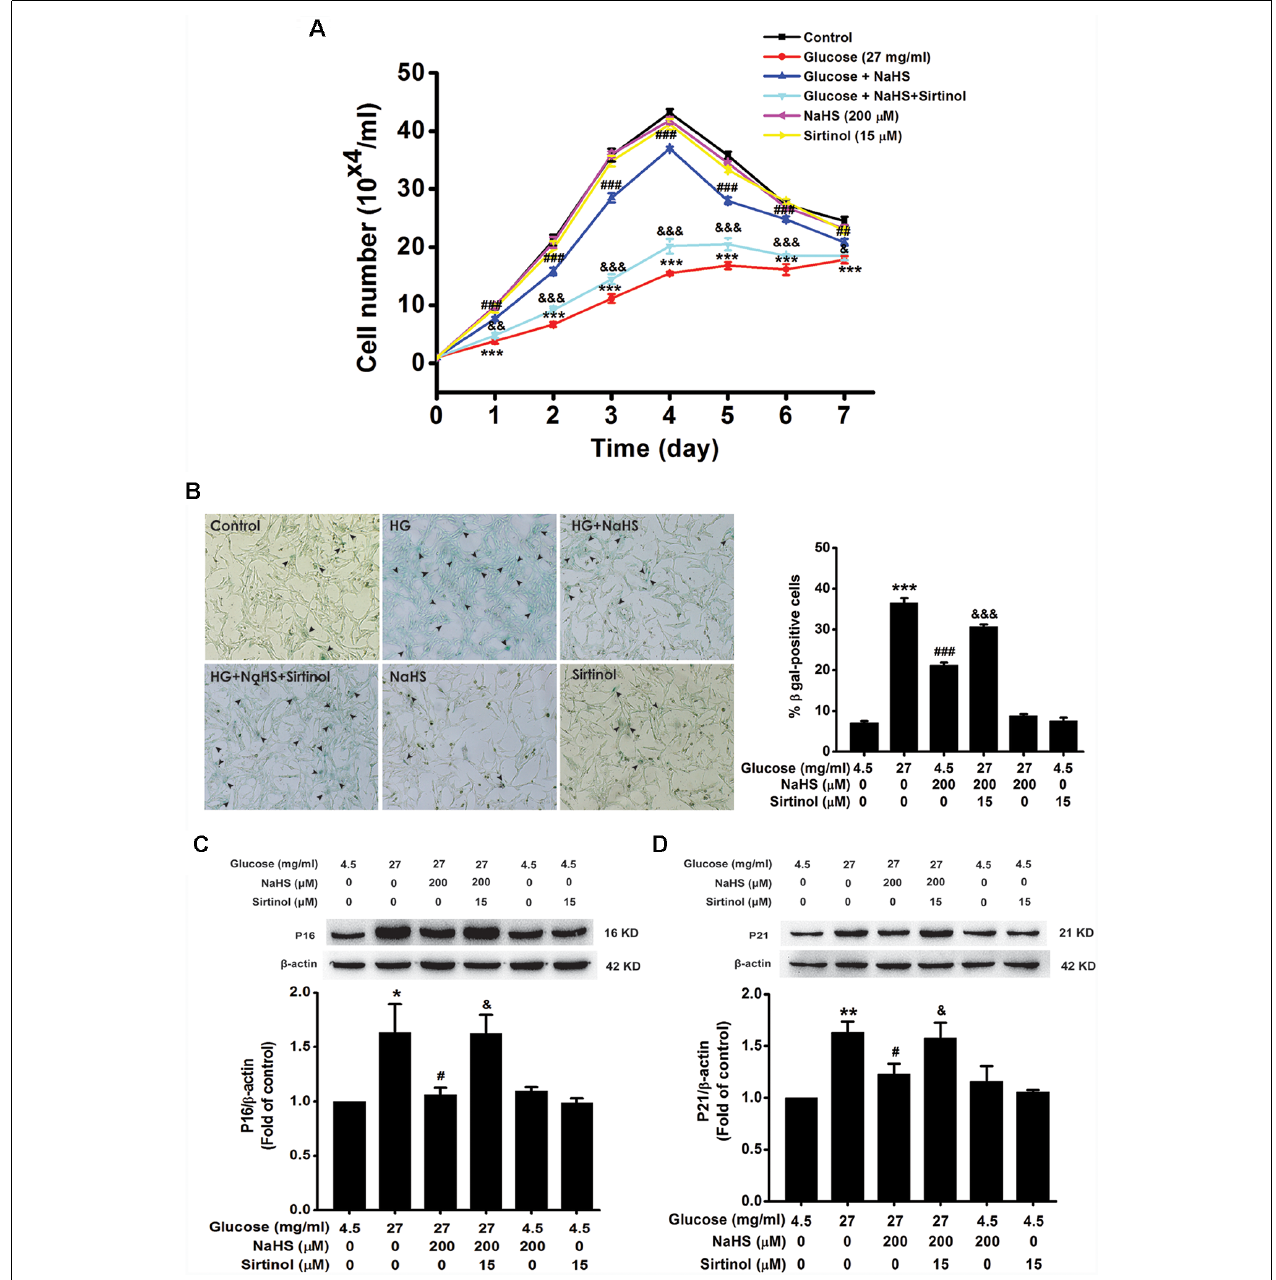
FIGURE 7 | Sirtinol reversed H 2 S-inhibited cellular senescence in HG-exposed HT22 cells. (A) Cell growth curves were generated by using Trypan blue stain assays. (B) Representative images of senescent cells that were stained for SA- β -gal (Left, Magnification × 10) and quantitative analysis of the SA- β -gal positive cell (Right). The black arrows indicate the senescent cells. (C,D) The expressions of LC3II/LC3I and P62 in HT22 cells were detected by Western blotting. Values were expressed as the mean ± SEM, n = 3. ∗ P < 0.05, ∗∗ P < 0.01, ∗∗∗ P < 0.001, vs. control group; # P < 0.05, ## P < 0.01, ### P < 0.001, vs. HG-treated alone group. & P < 0.05, && P < 0.001, &&& P < 0.001, vs. co-treated with NaHS and HG